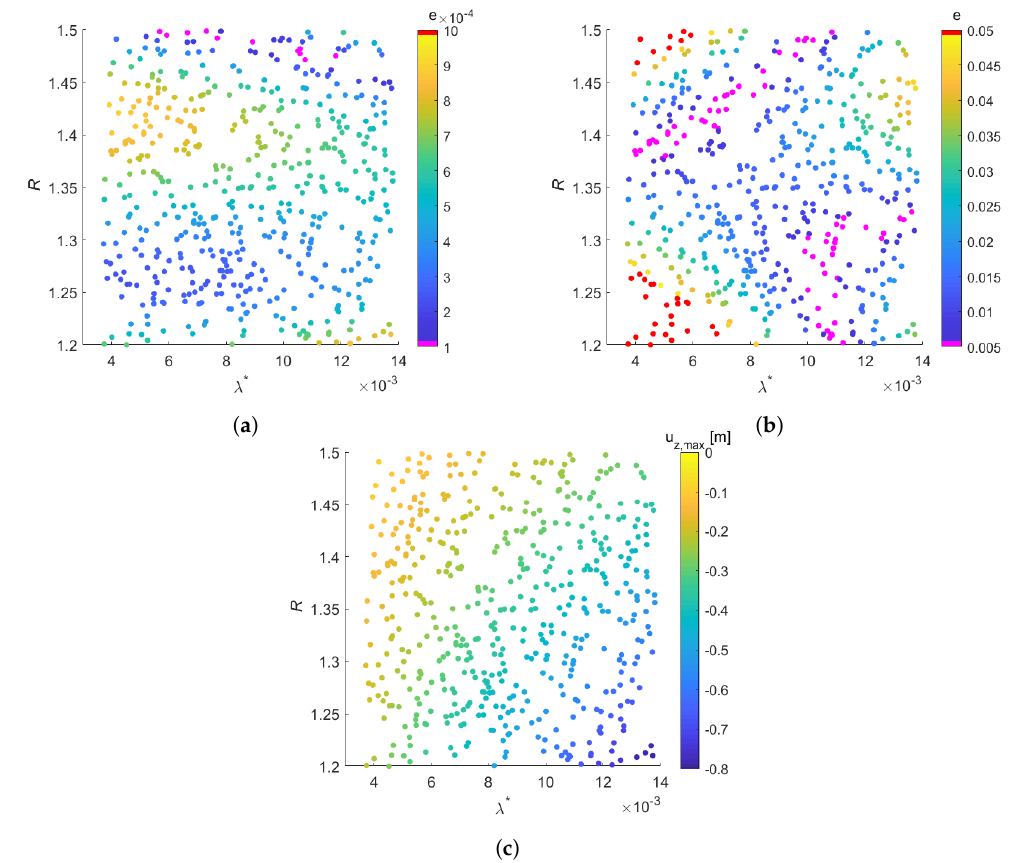
Figure 10. Error e = | µ u − p t | between the mean updated value and the true value for parameters ( a ) λ ∗ and ( b ) R at 500 randomly-sampled ’true’ reference simulations. Sub-panel ( c ) shows the maximum subsidence assimilated at each